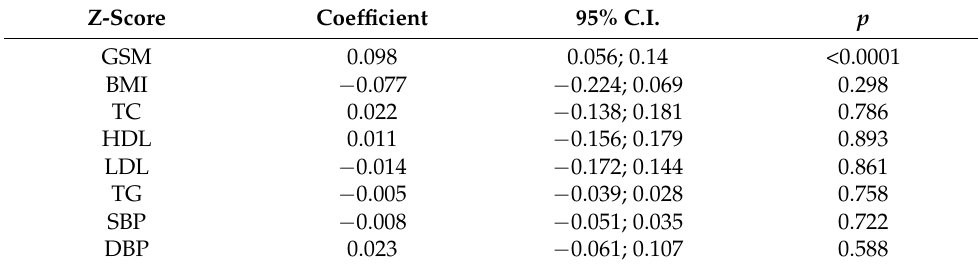
Table A2. Linear regression between the study variables at